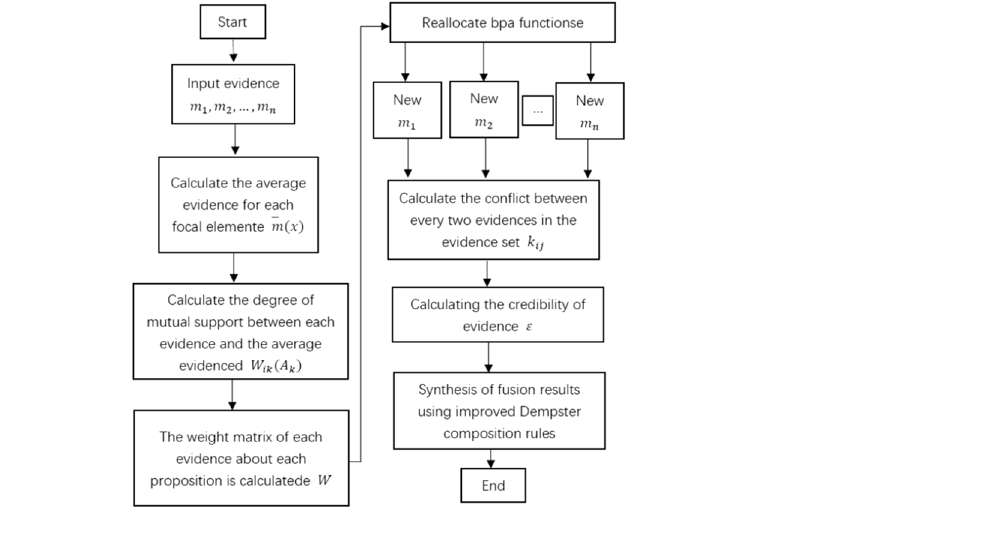
Figure 1. Conflict evidence processing flow